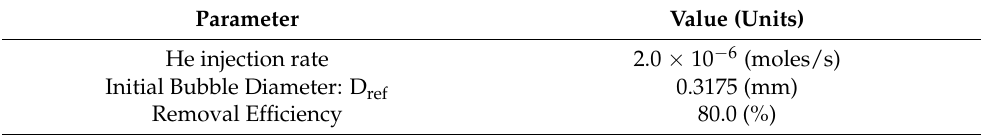
Table 2. Helium bubbling parameters